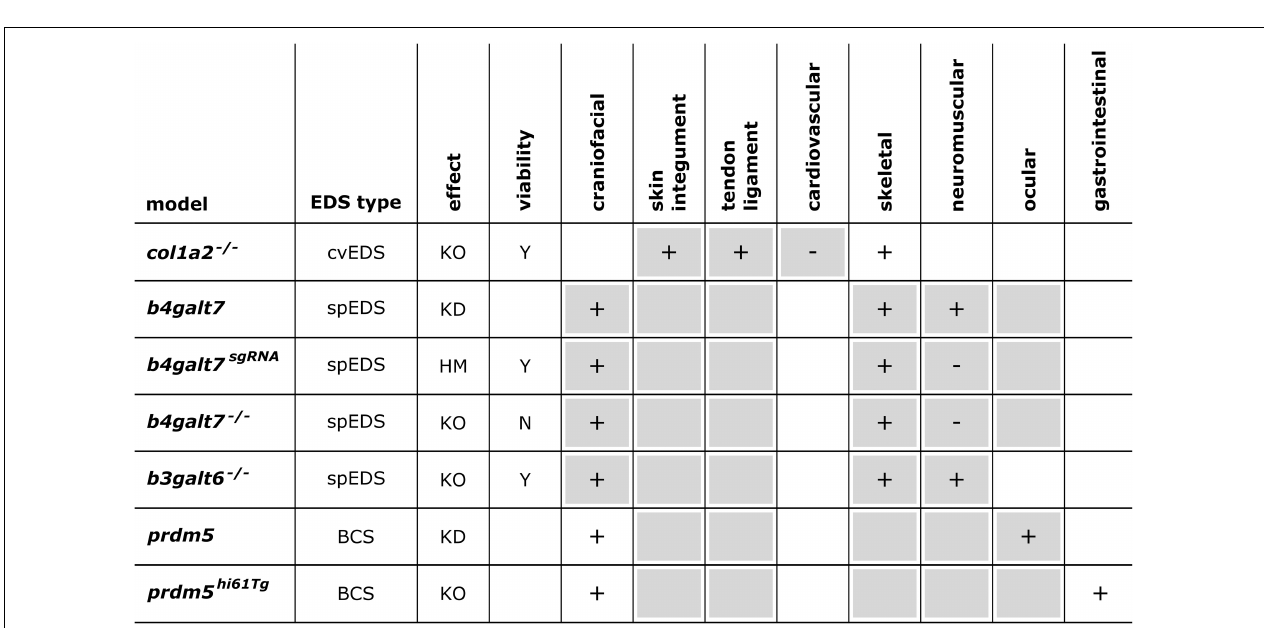
FIGURE 5 | Phenotypic characteristics of zebrafish models with defects in EDS-associated genes. The presence or absence of a phenotype in the zebrafish model is indicated with “+” or “-”, respectively, when investigated. A detailed description of the zebrafish phenotypes can be found in Supplementary Table 2 . The major and minor clinical characteristics in humans EDS patients as defined in the International EDS Classification, published in 2017, are indicated with a gray background (Malfait et al., 2017). BCS, brittle cornea syndrome; KO, knockout; KD, (morpholino-based) knockdown; HM, hypomorphic; Y, viable; N, not viable.